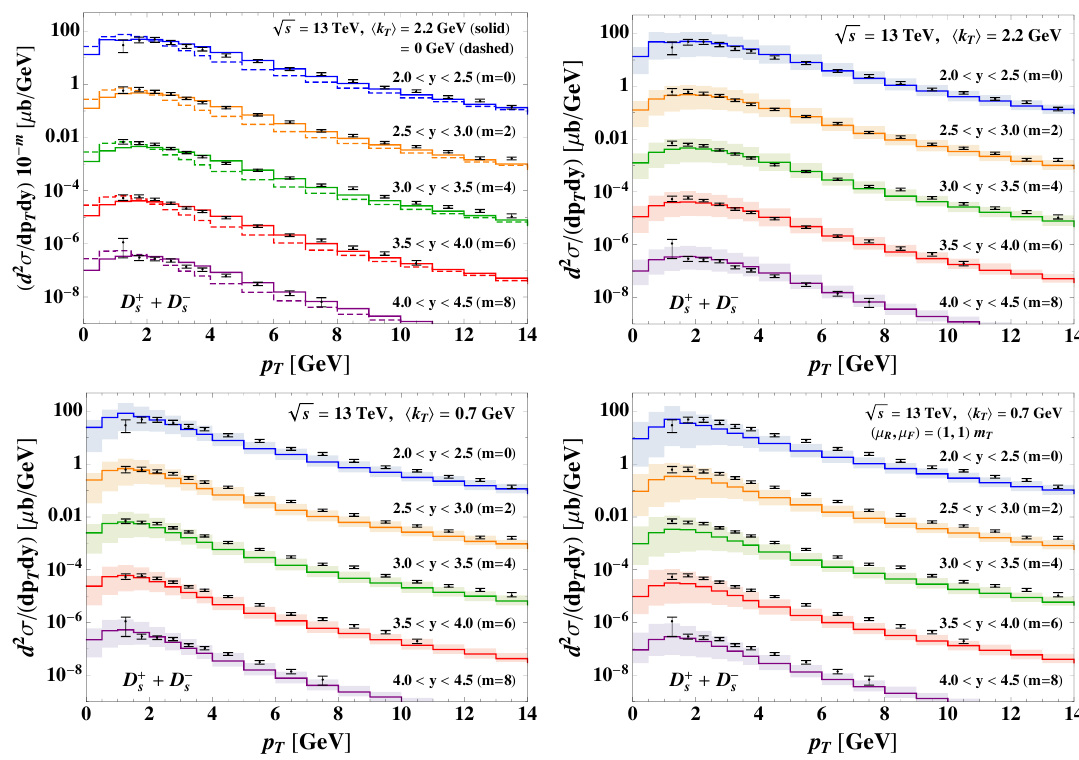
Figure 1 . Comparison between LHCb experimental data on double-di(cid:11)erential distributions in the meson p T and y for D (cid:6) production in pp collisions [33] and our QCD predictions. Data (and s predictions) for di(cid:11)erent (cid:1) y bins are shifted by 10 (cid:0) m where values of m = 0, 2, 4, 6 and 8. The upper left panel refers to the case N R = 1 : 0 and N F = 1 : 5, where ( (cid:22) R ; (cid:22) F ) = ( N R ; N F ) m T , both (cid:12)xing h k T i = 2 : 2 GeV and in the collinear approximation ( h k T i = 0 GeV). The upper right and lower left panels refer to the same scale con(cid:12)guration with the shaded band showing the uncertainty built by seven-point scale variation in the range N R;F = 0 : 5{2 for h k T i = 2 : 2 GeV (best (cid:12)t to data) and h k T i = 0 : 7 GeV (our default value), respectively. The lower right panel shows the same as lower left, but with ( N R ; N F ) = (1 ; 1) (conventional scale